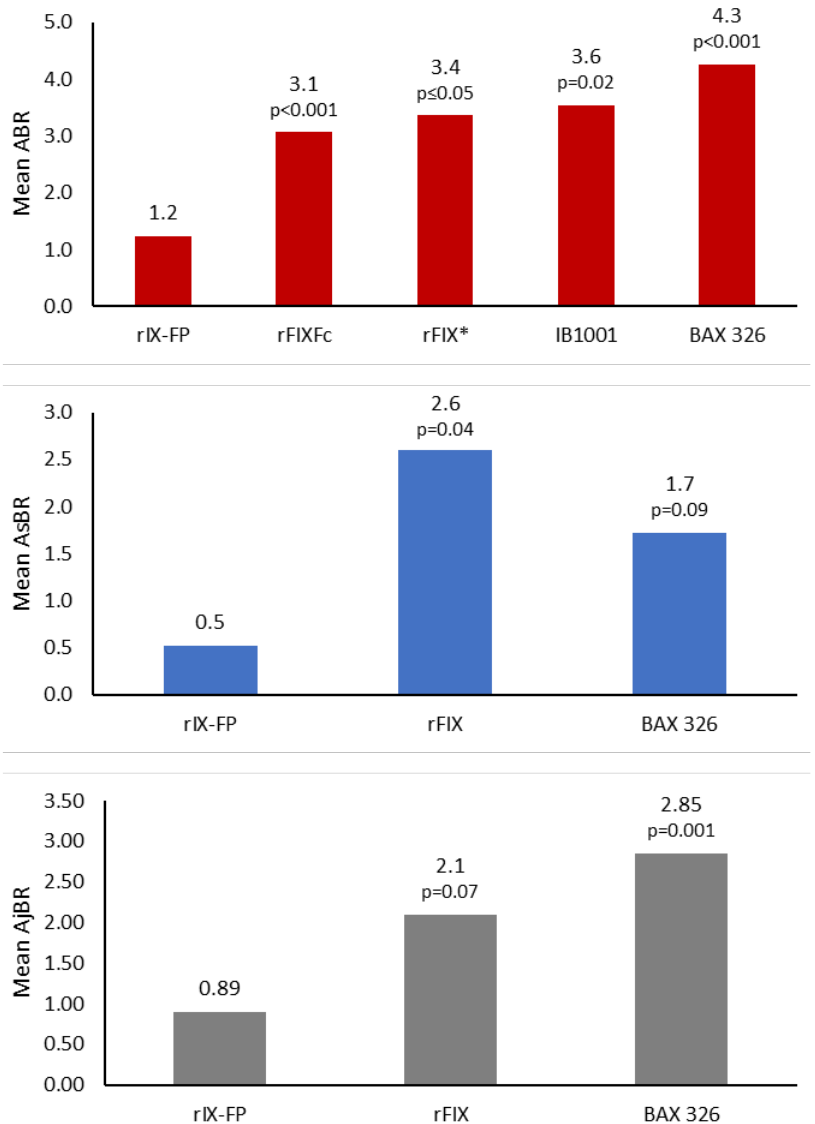
Figure 3. Efficacy of rIX-FP weekly prophylaxis compared with other rFIX products. * Mean ABR from Lambert et al.’s and Kavakli et al.’s studies. Figure adapted from Davis, J. et al., J. Med. Econ. 2019 , 22 , 1014–1021. Note, mean AsBR and mean AjBR data are not reported for rFIXFc or IB1001; mean ABR/AsBR/AjBR are not reported for N9-GP. Median doses for each product are as follow: rIX-FP, 40.3 IU/kg (7-day dosing) [8]; rFIXFc, 45 IU/kg (7-day dosing) [26]; rFIX, 100 IU/kg (7-day dosing) [27]; BAX 326, 50.5 IU/kg (2 × /weekly dosing) [28]; IB1001, 53 IU/kg (2 × /weekly dosing) [29]. ABR, annualized bleeding rate; AsBR, annualized spontaneous bleeding rate; AjBR, annualized joint bleeding rate; rFIX, recombinant factor